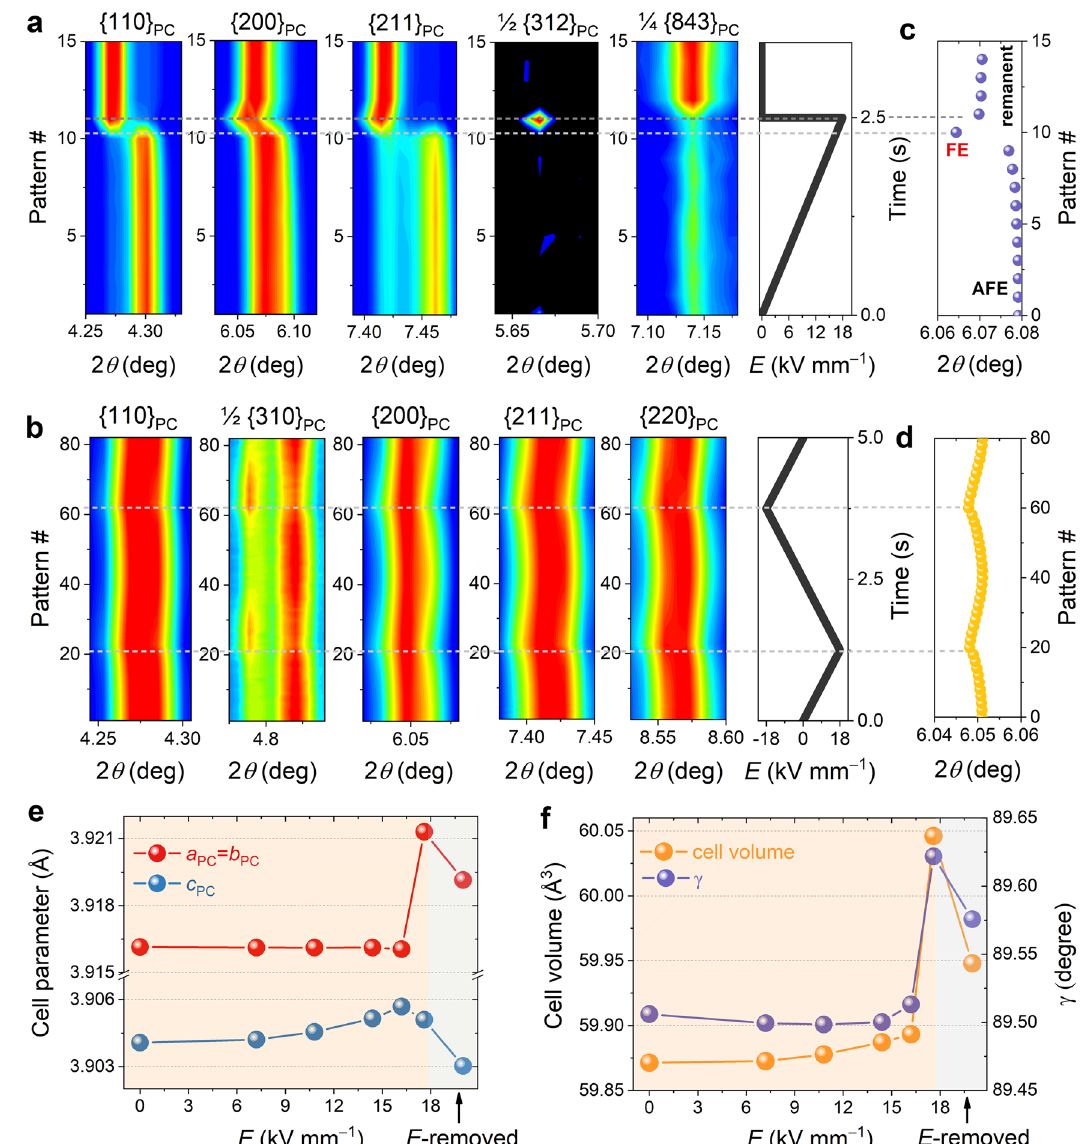
Fig. 5 | In situ high-energy XRD characterization of antiferroelectric and relaxor states. a Contour plots of representative primary and superlattice re fl ec- tions of the NN5SS_1.0Mn sample under the application of a unipolar electric fi eld of 18kVmm − 1 and b the NN9SS_1.0Mn sample under the application of a bipolar electric fi eld of 18kVmm − 1 . c Evolution of the {200} peak position for the